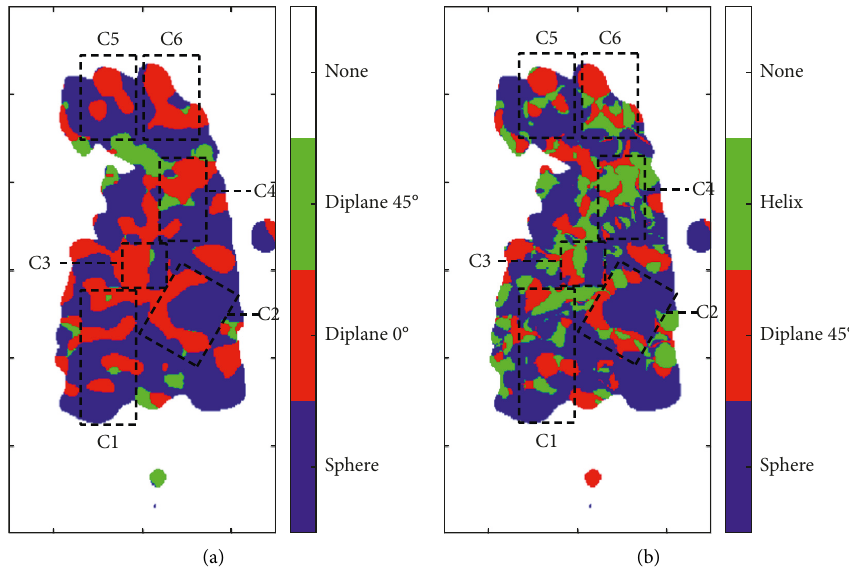
Figure 8: (a) Pauli and (b) Krogager decomposition results with a “winner takes all” classification